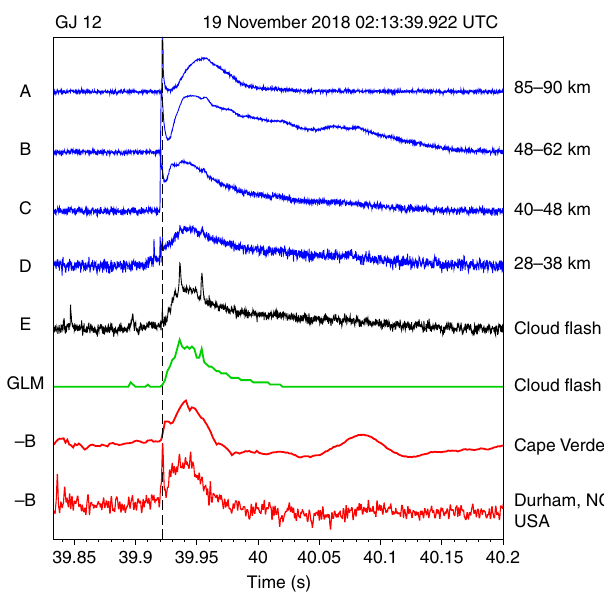
Fig. 5 The evolution of brightness with altitude in gigantic jets 7 and 12. Time-altitude-luminosity graphs at 0.2 ms temporal resolution for a GJ 12 and b GJ 7. The letters A – E indicate the altitude ranges used hereafter to track the evolution of luminosity